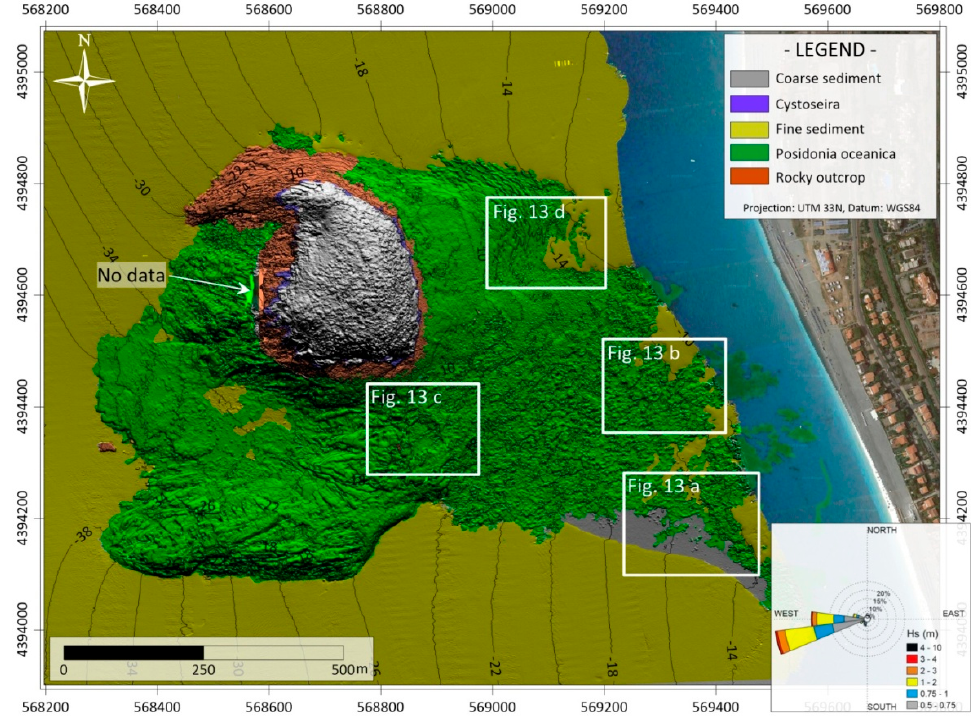
Figure 14. Seabed map classification of Cirella Island overlapped over high-resolution multibeam bathymetry. The map shows part of the analyzed areas in order to provide an example of the mapping outcomes. The inset at the bottom right shows the circular histogram of the wave directions and significant wave height (Hs) plotted using the directional wave time series recorded from 1979 to 2009, from NOAA wave watch III model [89] for the Mediterranean Sea at the Lat 41.33° and Long 12.50° coordinates.